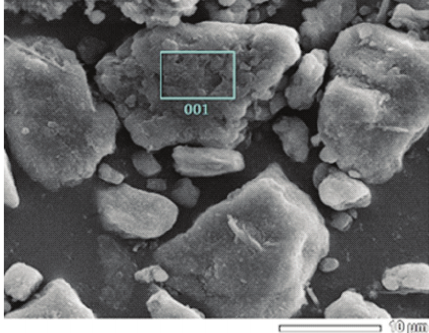
Figure 11: An SEM image of a commercial fire-retardant